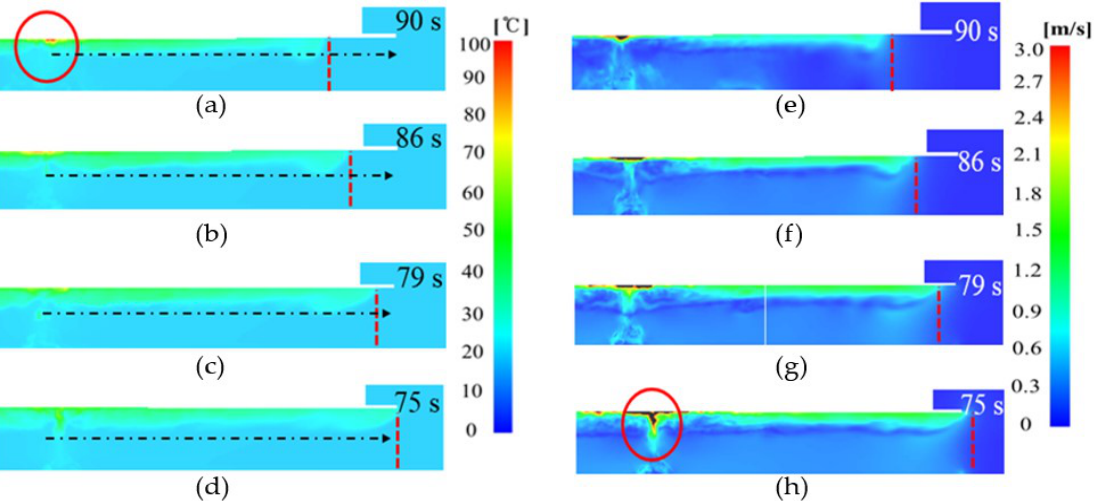
Figure 8. Temperature and smoke velocity distributions according to the initial time when the smoke exits the tunnel, ( a – d ) represents the various aspect ratio of 0.36, 0.72, 1 and 1.39, respectively. ( e – h ) represents the smoke velocity for varying aspect ratio of 0.36, 0.72, 1 and 1.39, respectively. The temperature of the upper part of the tunnel increases continuously as time goes by.